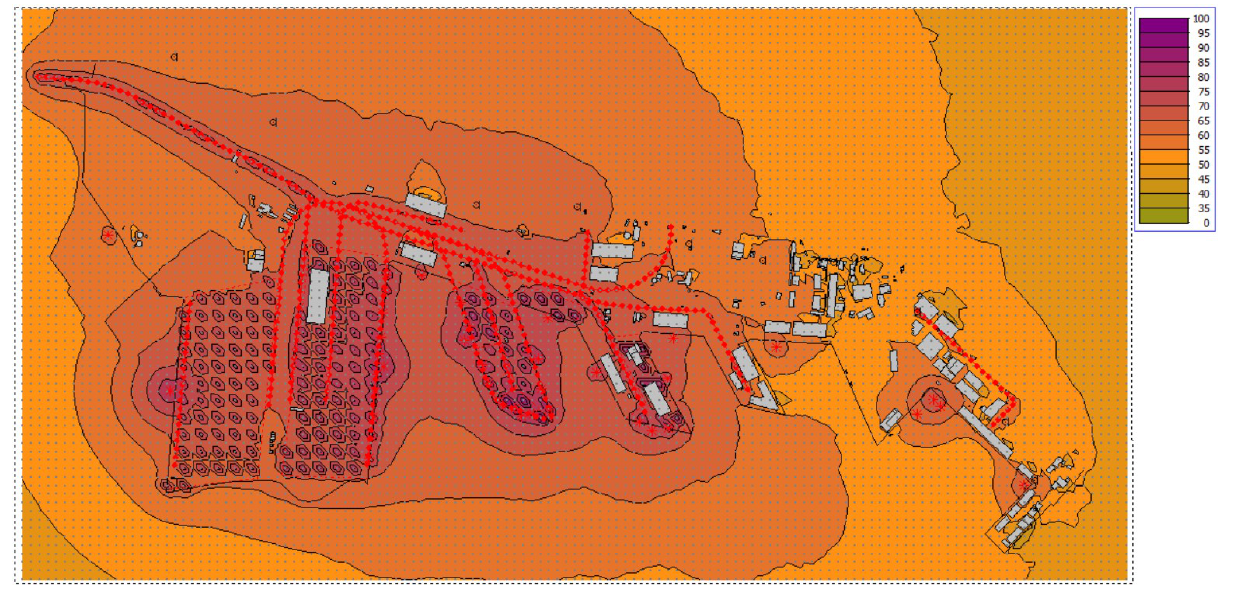
Figure 5: Noise map of the Port of Thessaloniki for the worst-case wind conditions (LDEN)